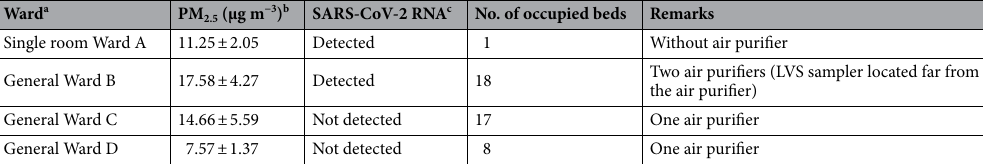
Table 2. Summary of the data collected from a teaching hospital at Kuala Lumpur. a Selected wards that were sampled consisting of different patient clusters: Single room ward A, an executive ward that hosts only one COVID-19 patient; General ward B was occupied by an institutional cluster; General Ward C was occupied by patients arriving from overseas; and General Ward D was occupied by migrant workers. b Average 48 hourly concentrations (with standard deviation) of PM 2.5 measured in different wards. c Detection of SARS-CoV-2 RNA on captured PM 2.5 at different